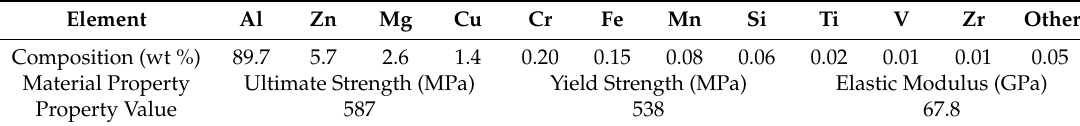
Table 1. Composition and mechanical properties of Al7075-T6.